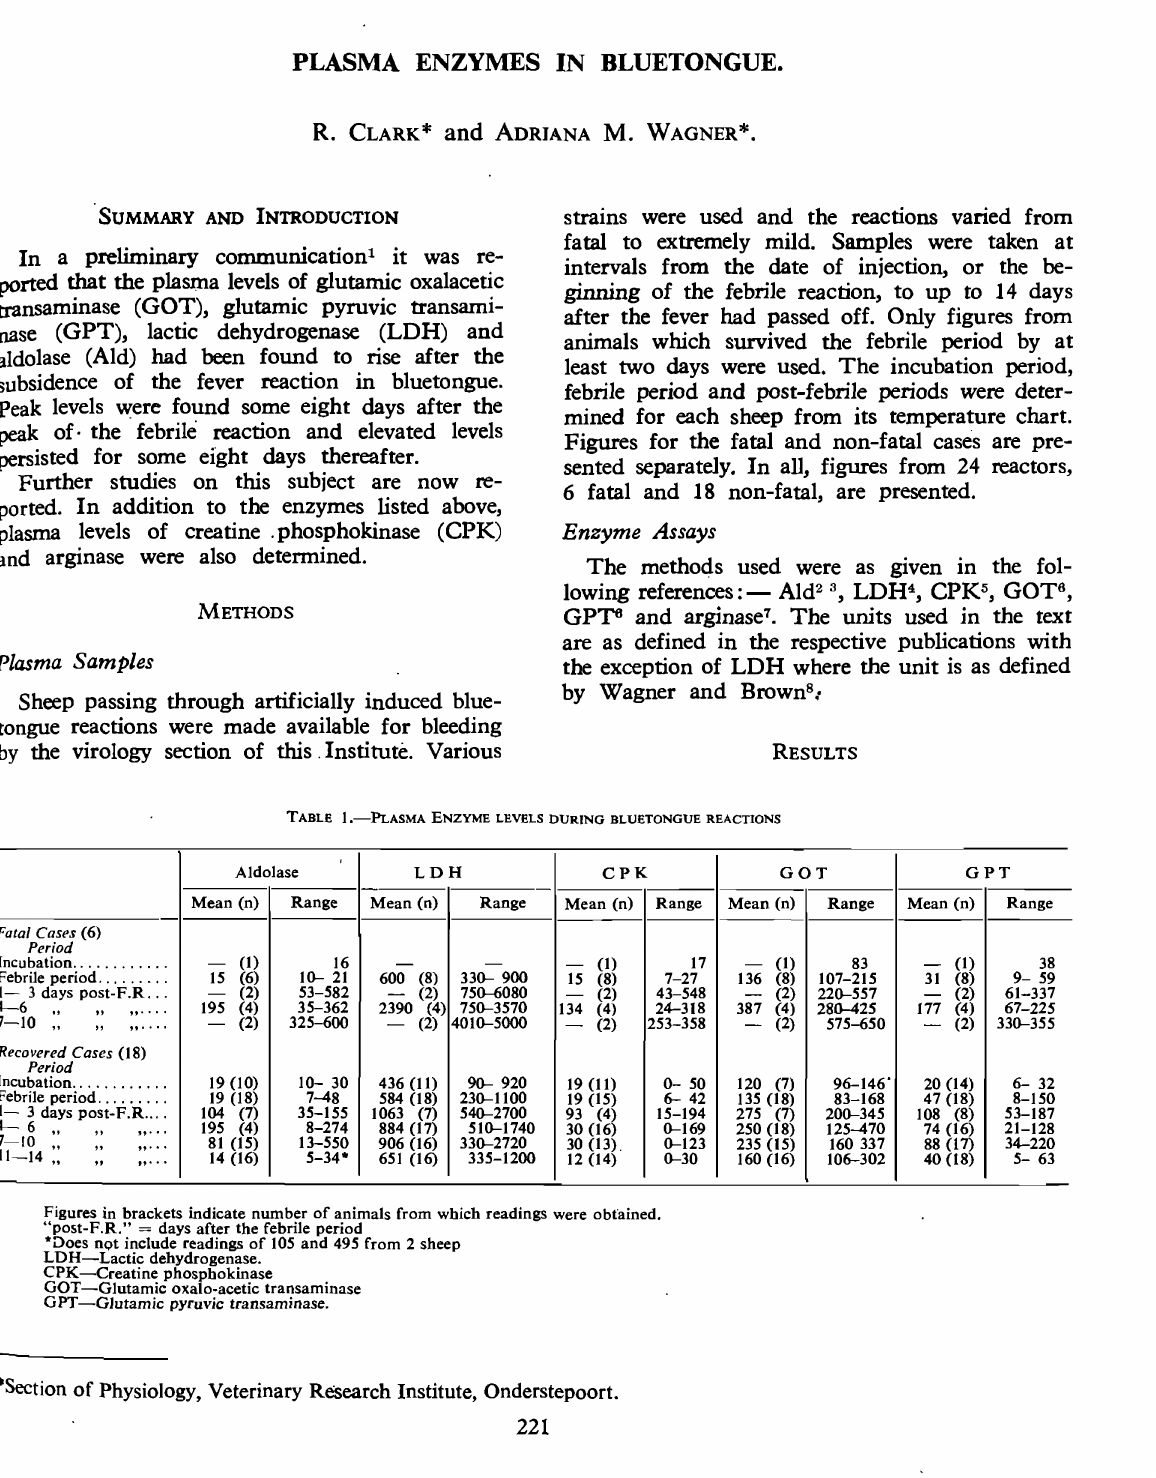
LDH-Lactic dehydrogenase. CPK-Creatine phosphokinase GOT-Glutamic oxalo-acetic transaminase GP'J' -Glutamic pyruvic